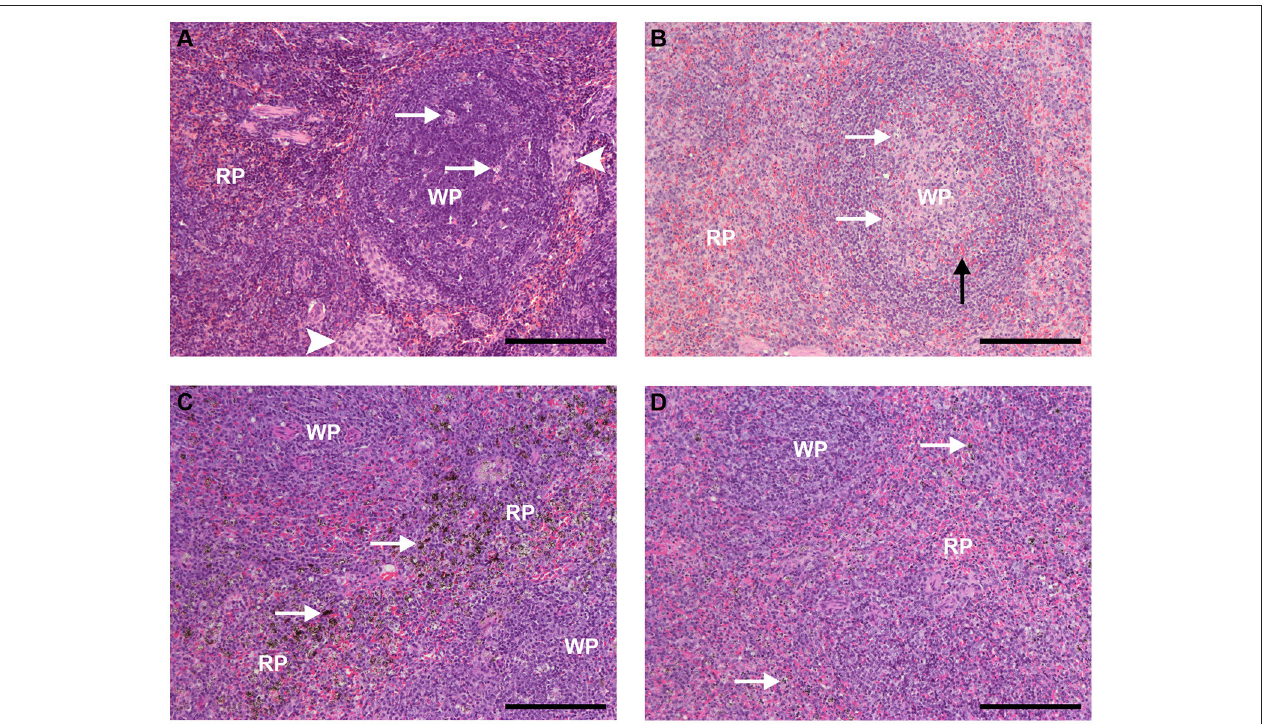
FIGURE 6 | Spleen sections HE staining (bar: 200 µ m). (A) Spleen of an uninfected, control animal that received PBS (code PA11). (A) B-cell follicle (WP, white pulp) is shown, with a few apoptotic centers (arrows); clusters of monocyte/macrophages, typical of Saimiri spleens, are present (arrowheads). The red pulp (RP) shows typical architecture, densily populated with small-nuclei, dark-stained cells, and red blood cells (red stain) flowing through. (B) Spleen of an uninfected Saimiri inoculated with CL 1 mL (code V3). In general, the splenic structure was preserved, but cell density was apparently smaller as compared to animals that received PBS, with predominance of cells with light-stained nuclei; penetration of red blood cells inside B-cell follicle was observed (black arrow); apoptotic centers (arrows), which are dependent on macrophages, and clusters of monocyte/macrophages were decreased (clusters of monocytes absent in this image). (C) Spleen of a P. falciparum -infected Saimiri that received PBS (code 141: treated at day 17, with 0.69% parasitemia, killed 5 days later). Emphasis is given to the distribution of hemozoin (seen as dark, granulated stain - arrows), which could be found throughout the red pulp (RP); loss of well-defined limits between the RP and the white pulp (WP) was observed. (D) Spleen of a P. falciparum -infected Saimiri that received CL 1 mL (code 272: treated at day 11, with 22 % parasitemia, killed 5 days later). The amount of hemozoin (arrows) was substantially decreased compared to infected animals that received PBS, and seen as small black dots. As in (C) , loss of well-defined limits between the red pulp (RP) and the white pulp (WP) was